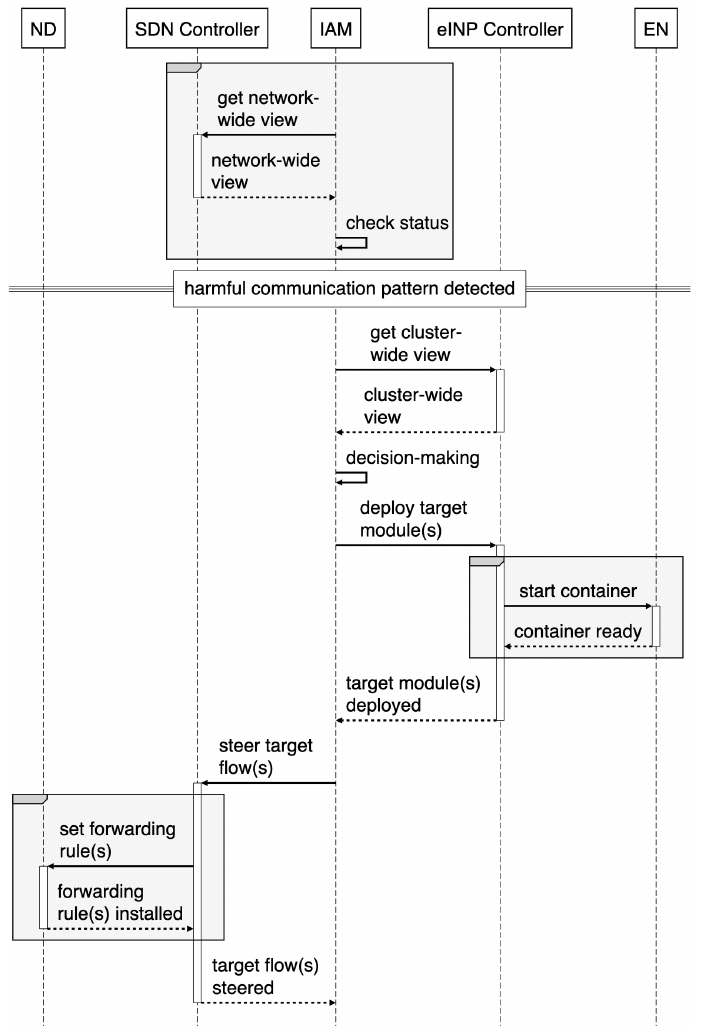
Figure 3. Sequence diagram detailing how the architectural components interact with each other to deal with a harmful communication pattern. The IAM jointly orchestrates the SDN and eINP controllers, which, in turn, dictate the behavior of NDs and ENs,